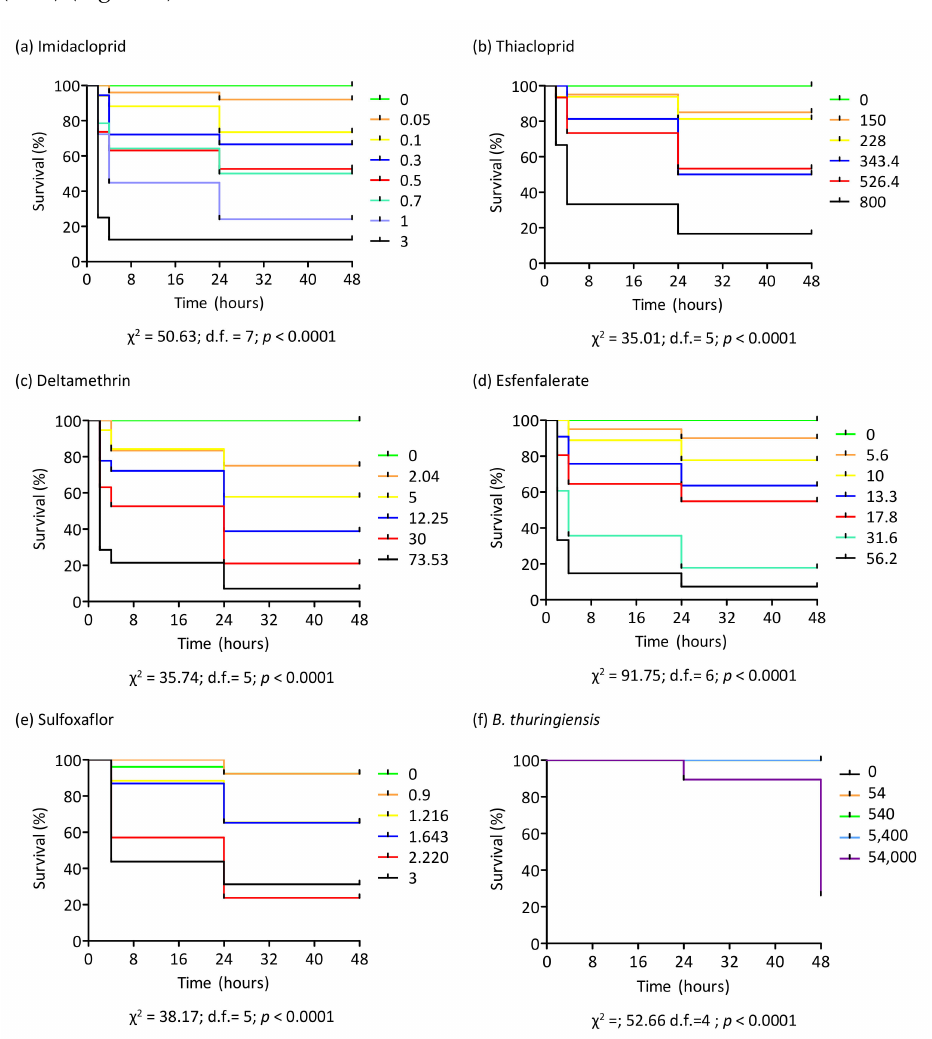
Figure 3. Kaplan–Meier survival analyses for B. terrestris workers when they were exposed for 48 h to different concentrations of the insecticides imidacloprid, thiacloprid, deltamethrin, esfenvalerate, sulfoxaflor and B. thuringiensis . Concentrations are represented by different colors and are expressed in ppm ( W/V ). The probability of survival (%) is defined as the probability that an individual survives longer than time